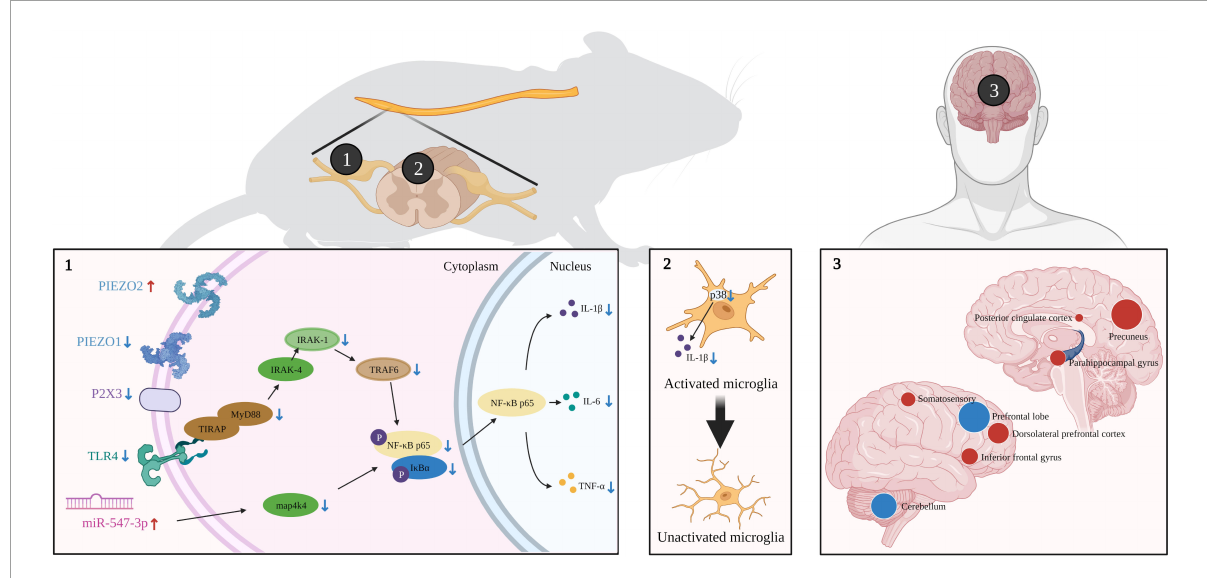
FIGURE1 The analgesic mechanism of tuina [images with permission created with BioRender. https://biorender.com